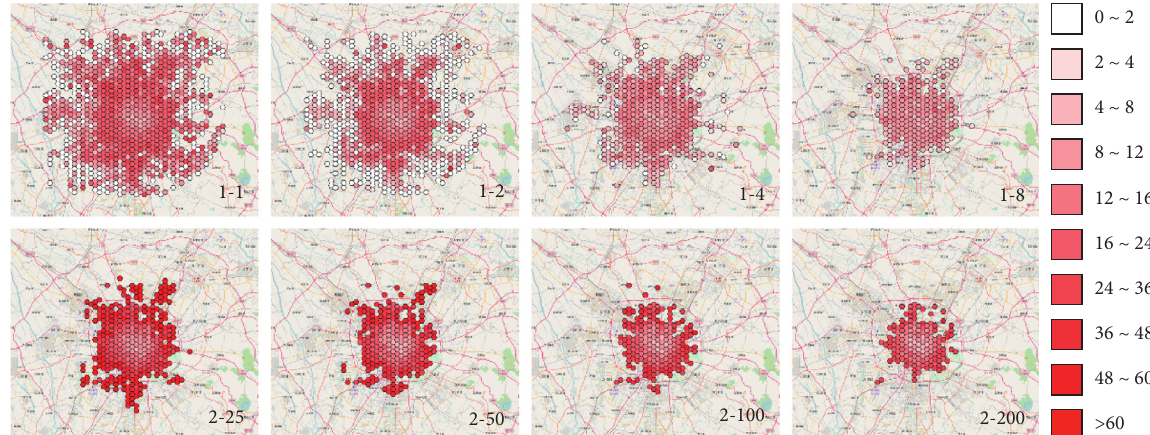
Figure 5: Spatial distribution of SMAPE of the H-ConvLSTM model under different thresholds.